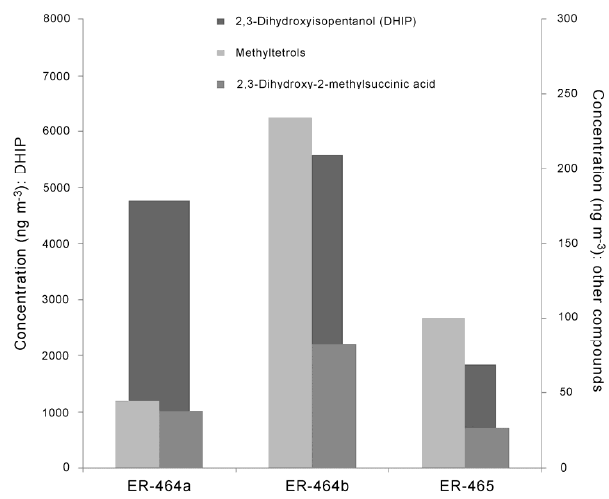
Fig. 6. Concentrations (ng m -3 ) of DHIP, methyltetrols (2-methylerythritol + 2-methylthreitol), and 2,3- dihydroxy-2-methylsuccinic acid as KPA.